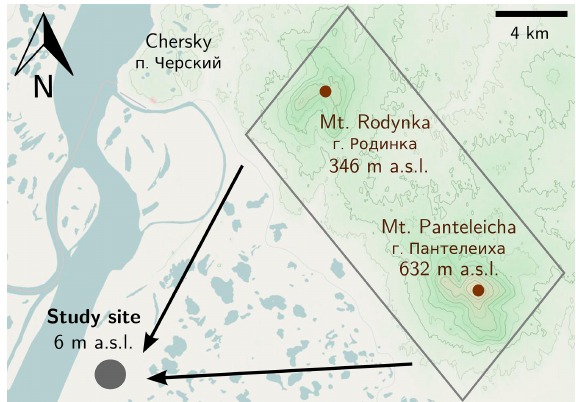
Figure 7. Flow path span of potential cold-air drains from the ridge between Mount Rodynka and Panteleicha through the flat floodplains of Kolyma river to the study site (map modified from http://www.openstreetmap.org, last access: 24 June 2015, copyright by OpenStreetMap contributors under Creative Commons License